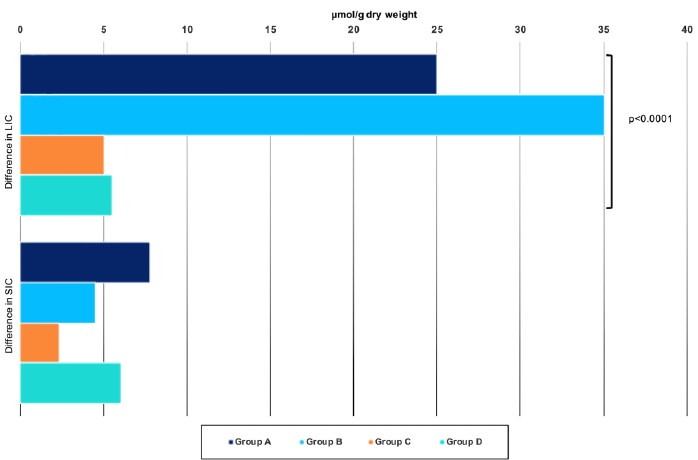
Figure 1. Evolution of liver iron concentration before and after iron therapy in 54 dialysis pa- tients. Median liver iron concentration before and after iron therapy in: Group A: 11 patients treated with 1.2 g iron sucrose; Group B: 14 patients treated with 2.4 g iron sucrose; Group C: 15 patients treated with ferric carboxymaltose; Group D: 14 patients treated with iron isomaltoside. p value with Wilcoxon test.